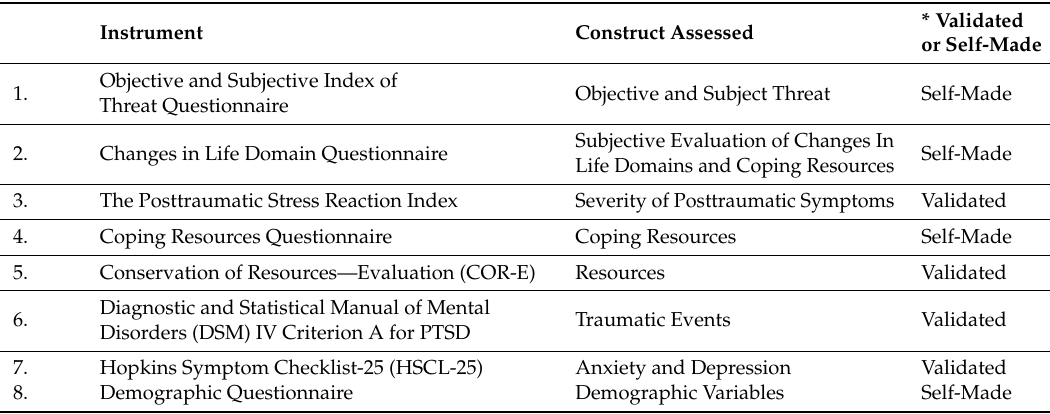
Table A1. Various assessment instruments used to measure